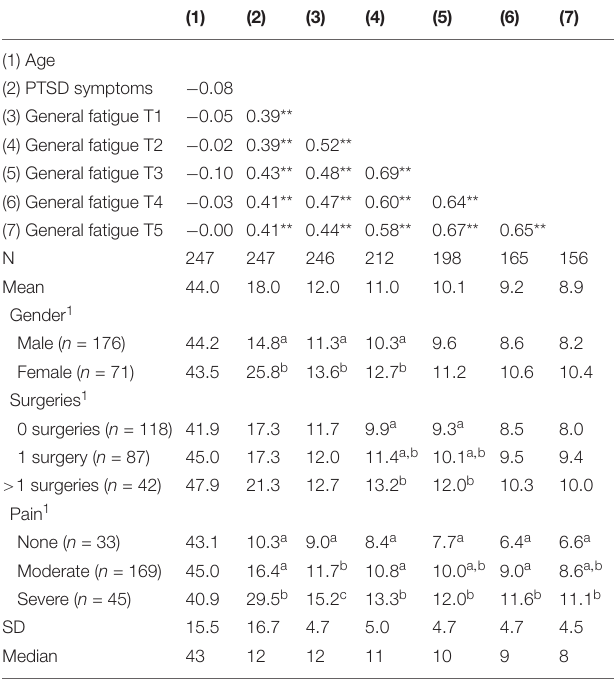
TABLE 2 | Descriptives and bivariate pearson correlation matrix of study variables and general